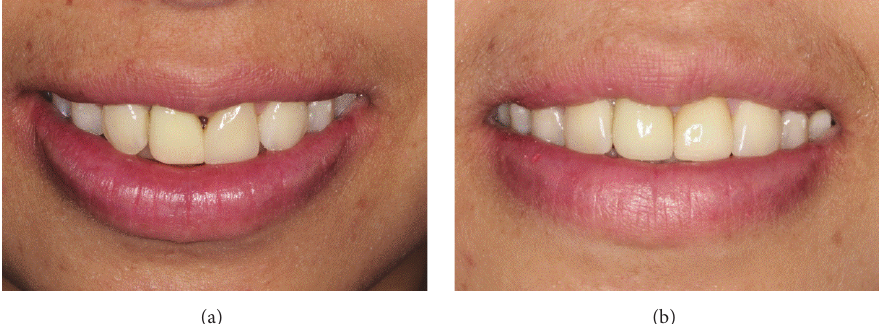
Figure 3: Front views of intraoral photographs of the patient’s smile. (a) After placement of provisional restorations. (b) At 2 weeks after completing